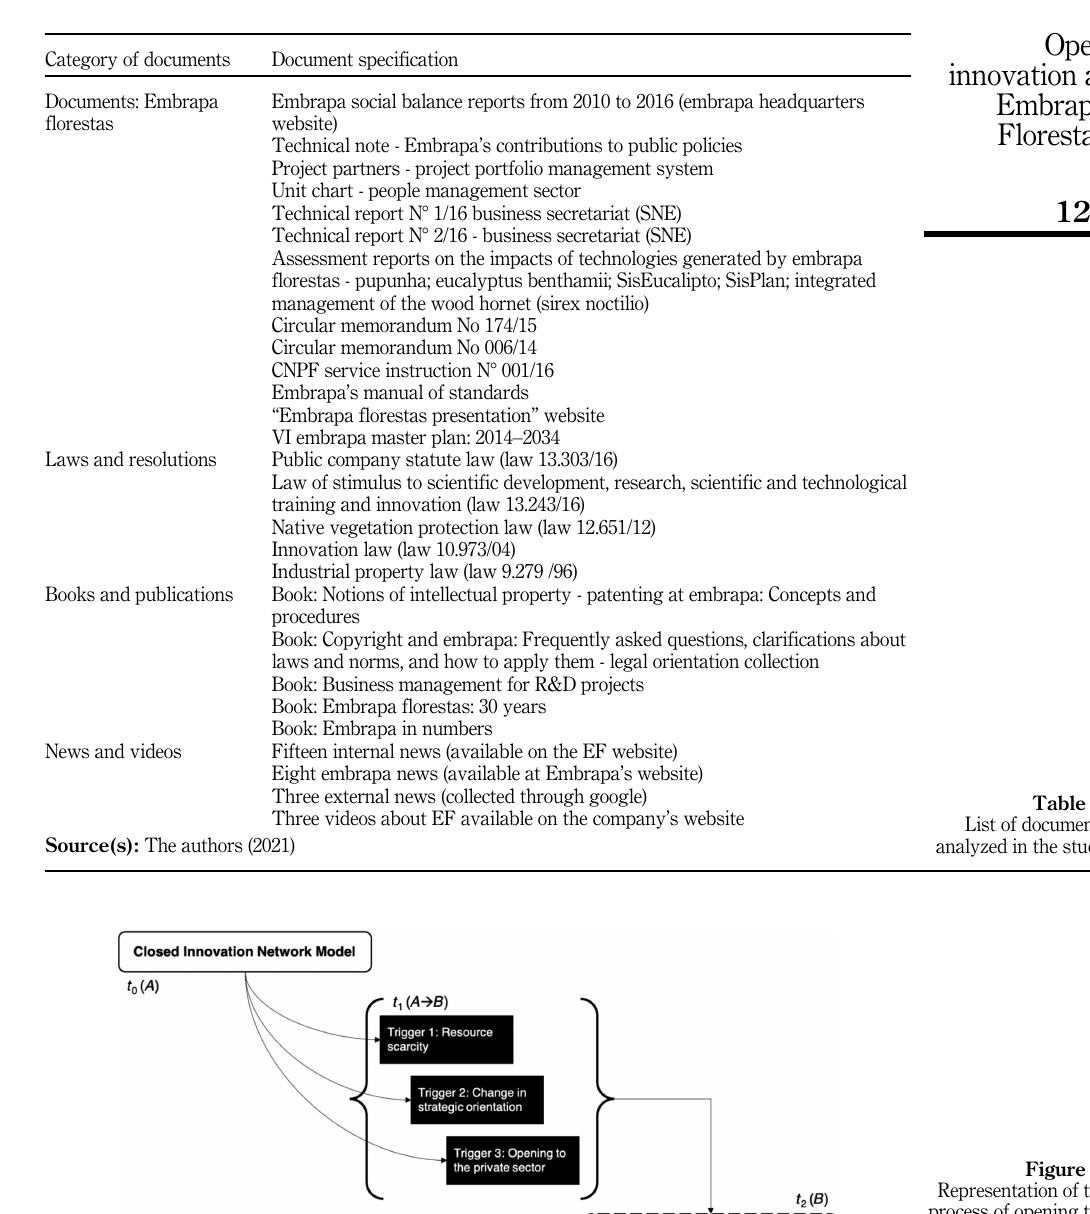
Figure 1. Representation of the process of opening the Embrapa